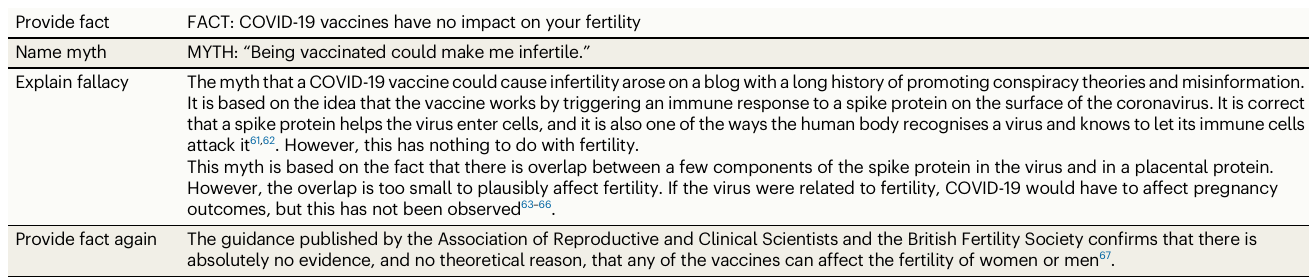
Table 2 | Example of a fact-sandwich to debunk misinformation Provide